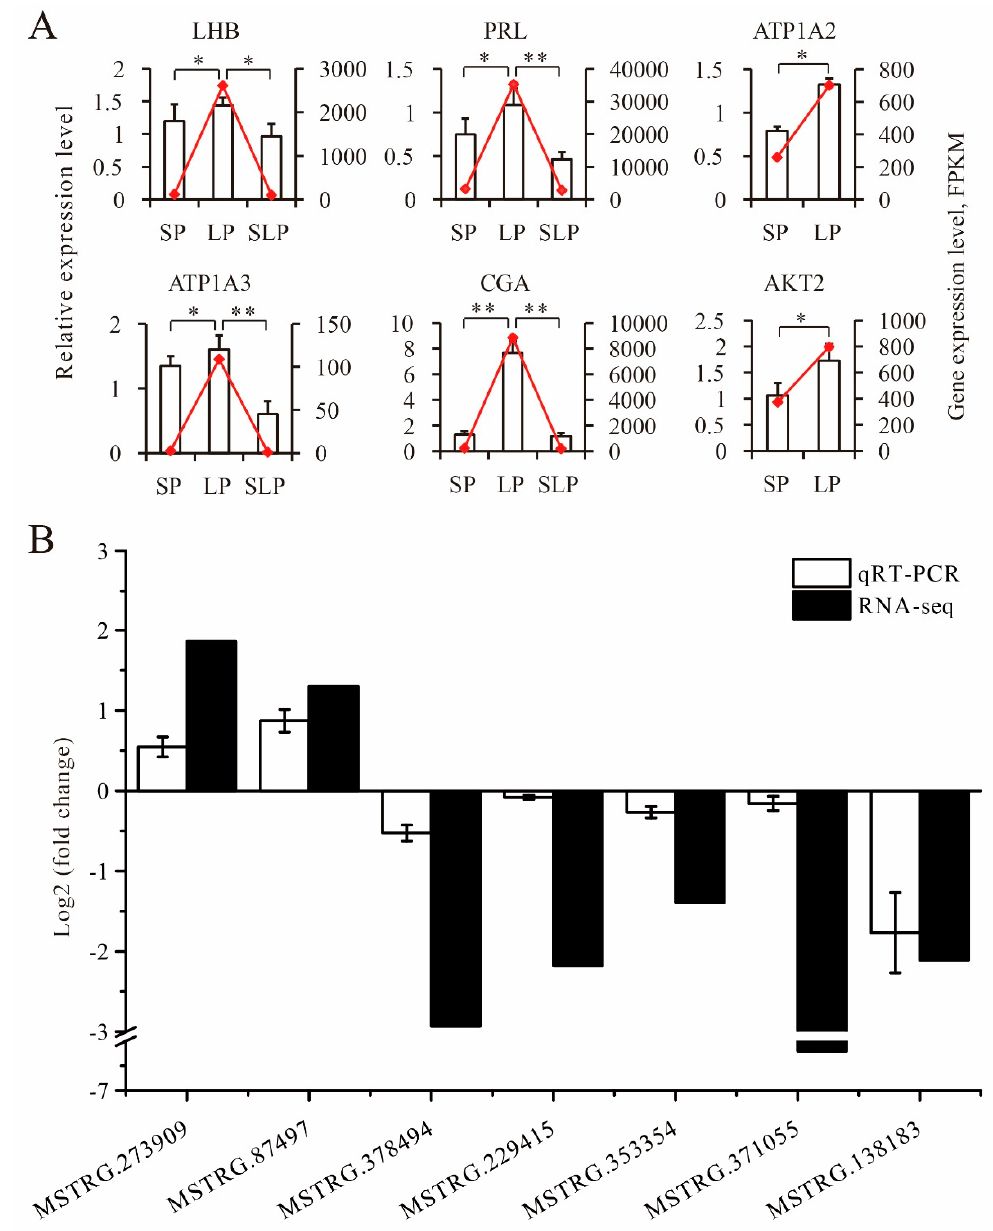
Figure 8. Validation of the expression of differentially expressed genes by qRT-PCR. ( A ) Validation of the expression of differentially expressed mRNAs by qRT-PCR. Data from the qRT-PCR are shown as columns and on the Y-axis on the left, while the data from RNA-Seq are shown as lines and on the Y-axis on the right. Data are represented as the mean ± SD, n = 3 per group. * P < 0.05, ** P < 0.01. ( B ) Validation of the expression of differentially expressed lncRNAs by qRT-PCR.